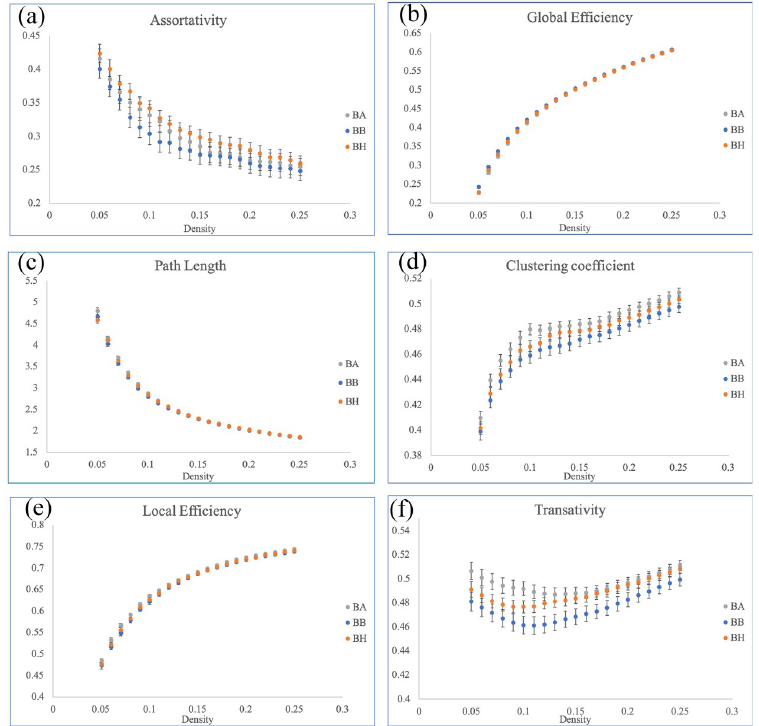
Fig 4. Topological parameters. (a) Both the cancer survivor groups demonstrated a decreasing trend in assortativity. Significant AUC was noted in the comparisons between the C+ and C- groups for (b) global efficiency, (c) characteristic path length, (d) clustering coefficient, (e) local efficiency, and (f) transativity. No significant differences was noted for AUC comparisons between both the cancer survivor groups and the control group.